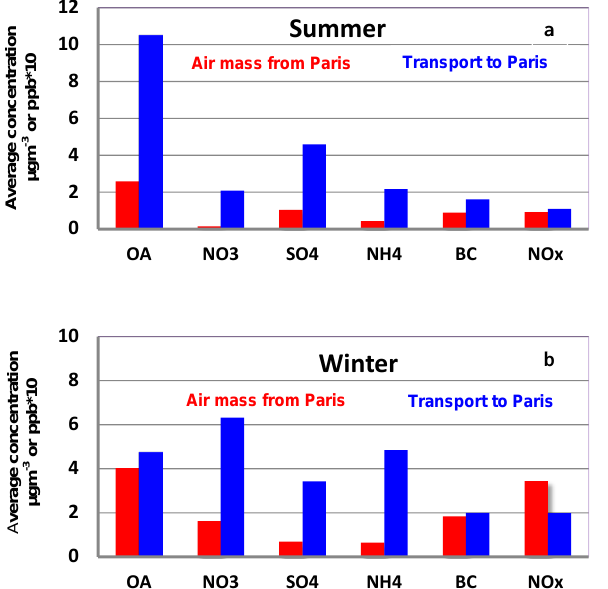
Figure 2. PM 1 components (µgm − 3 ) and NO x (ppb × 10) at the NE suburban site for air masses arriving from SW (red bars) and NE sectors (blue bars); air masses originating from the SW sector sample emissions from Paris, those from the NE sector represent continental type air masses moving towards Paris: (a) for summer and (b) for winter.